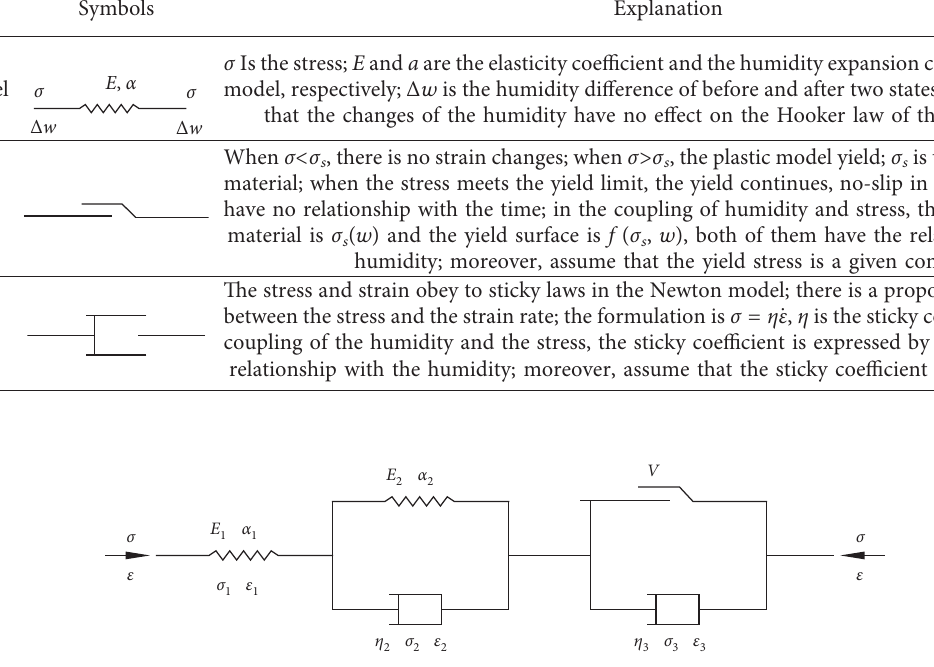
Figure 2: The Nishihara model under the humidity